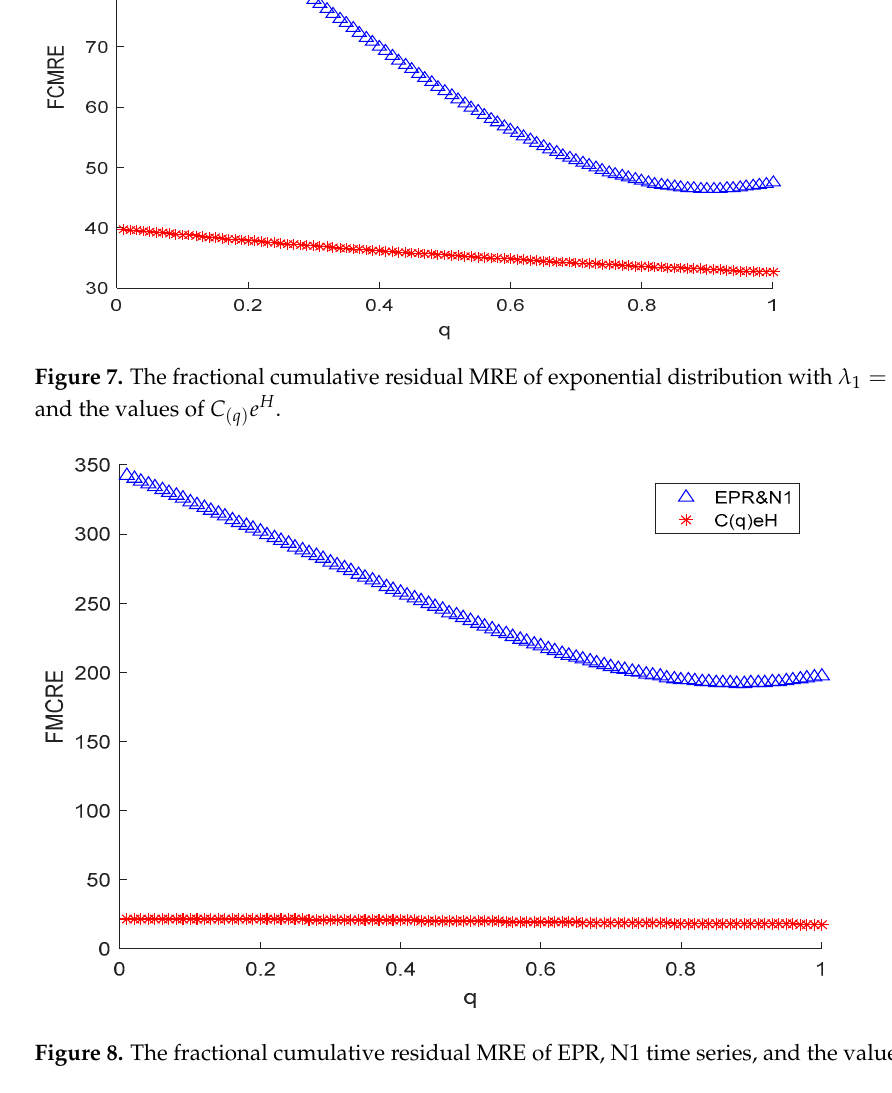
Figure 8. The fractional cumulative residual MRE of EPR, N1 time series, and the values of ( )